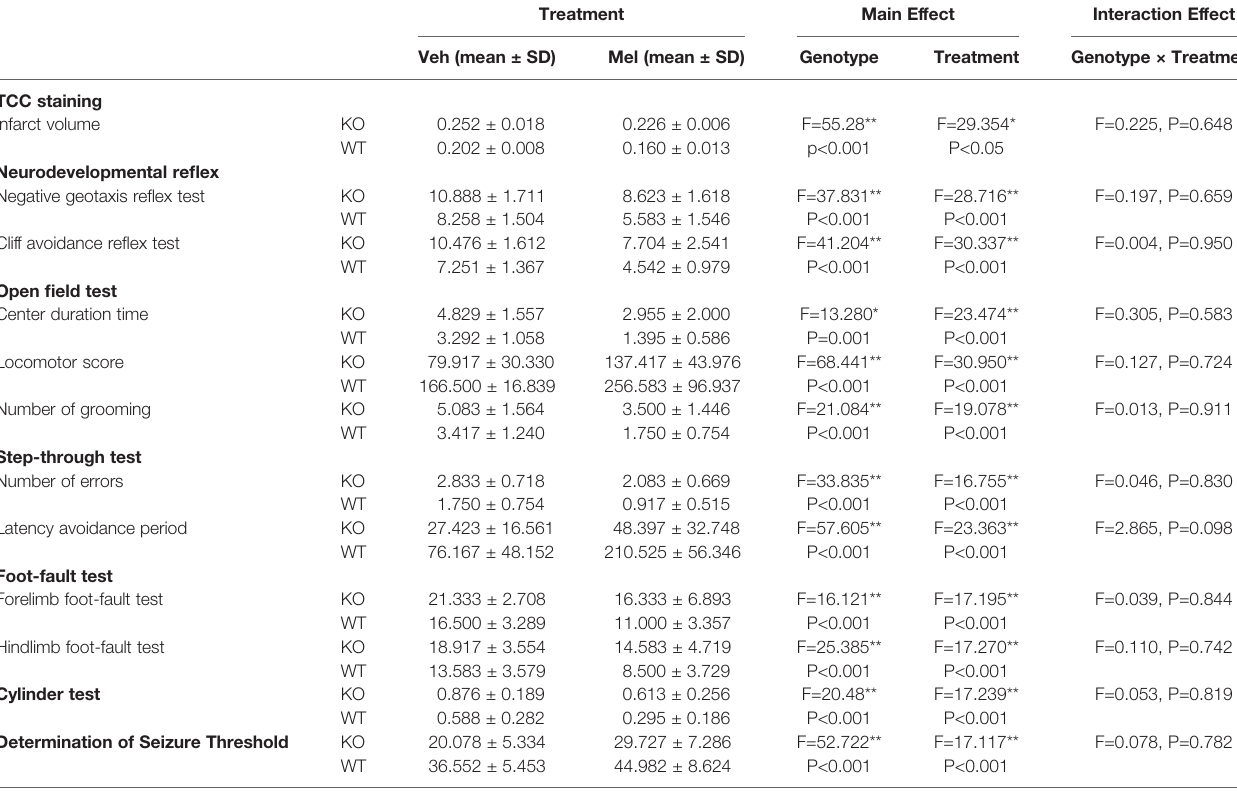
TABLE 1 | Signi fi cant results for two-way analysis of